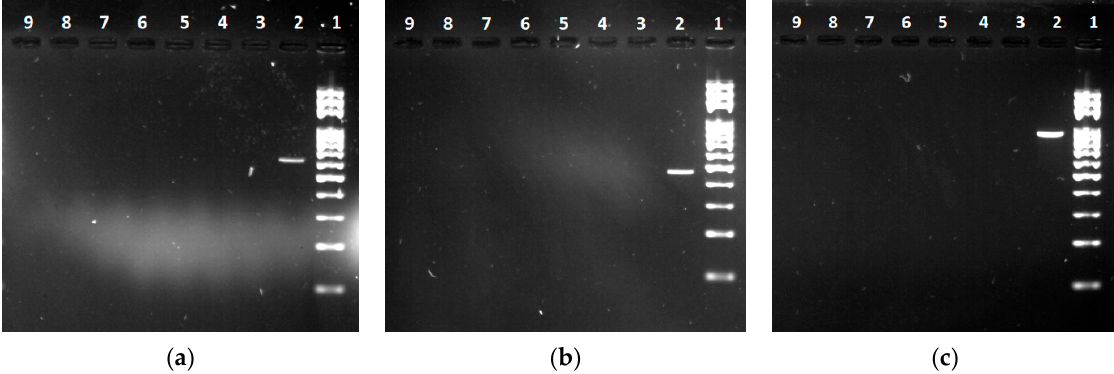
Figure 5. The specificity of primer pairs used in conventional PCR. ( a ) DNA amplicons of Penicillium ( P. ) reference strains using the VERF/VERR primer pair. Line 1: 100 bp ladder standard; Line 2: P. verrucosum (ATCC ® 44407 ™ ); Line 3: negative control; Line 4 to 9: reference strains P. commune (CCM F-327), P. crustosum (CCM 8322), P. chrysogenum (CCM F-362), P. brevicompactum (CCM 8040), P. glabrum (CCM F-310), P. expansum (CCM F-576); ( b ) DNA amplicons of Penicillium reference strains using the COMF/COMR primer pair. Line 1: 100 bp ladder standard; Line 2: P. commune (CCM F-327); Line 3: negative control; Line 4 to 9: reference strains P. verrucosum (ATCC ® 44407 ™ ); P. crustosum (CCM 8322), P. chrysogenum (CCM F-362), P. brevicompactum (CCM 8040), P. glabrum (CCM F-310), P. expansum (CCM F-576); ( c ) DNA amplicons of Penicillium reference strains using the COMF/COMR primer pair. Line 1: 100 bp ladder standard; Line 2: P. crustosum (CCM 8322); Line 3: negative control; Line 4 to 9: reference strains P. verrucosum (ATCC ® 44407 ™ ); P. commune (CCM F-327), P. chrysogenum (CCM F-362), P. brevicompactum (CCM 8040), P. glabrum (CCM F-310), P. expansum (CCM F-576).